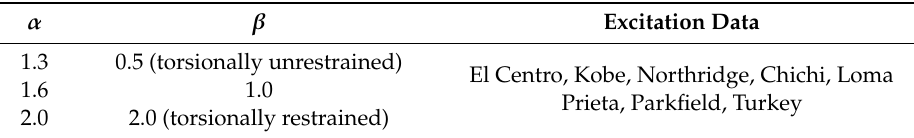
Table 2. Parameters considered in the time history